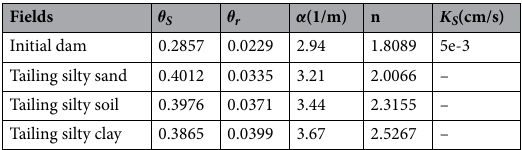
Table 1. The basic calculation parameters of the V-G model.